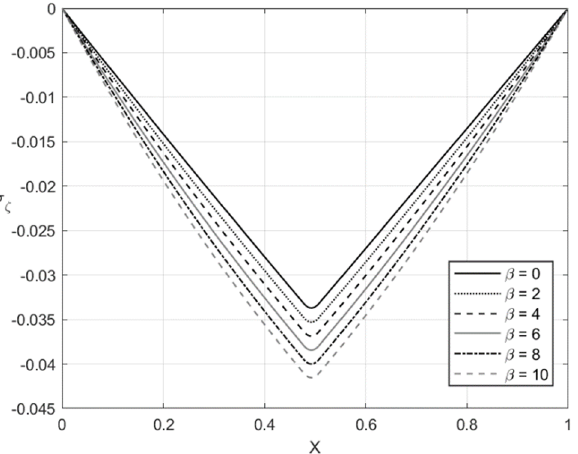
σ = 0.06 H r = at , 0 f , and sev- σ = CD 0.06 H r = at , 0 f , and sev- CD